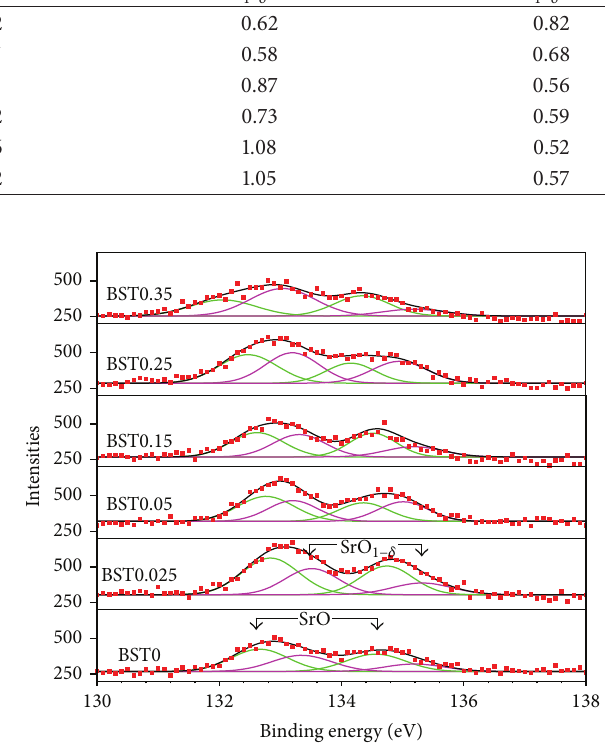
Figure 7: The fitting XPS spectra of Ti 2p deconvolution with Gaussian function.